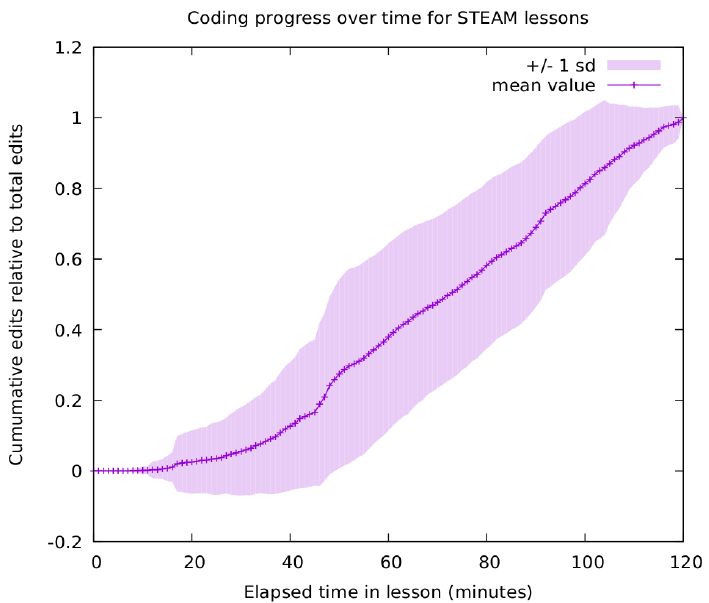
Fig. 6. Cumulative edits made in the lessons against time for all students in STEAM lessons. The number of edits is normalised against the total number of